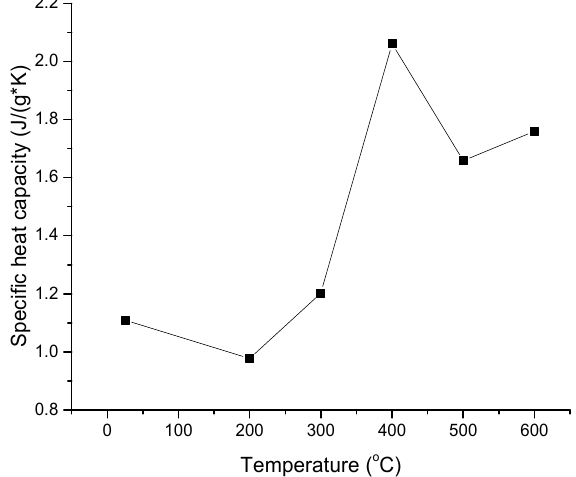
Figure 10. Variation of the specific heat capacity of the oil shale with temperature.